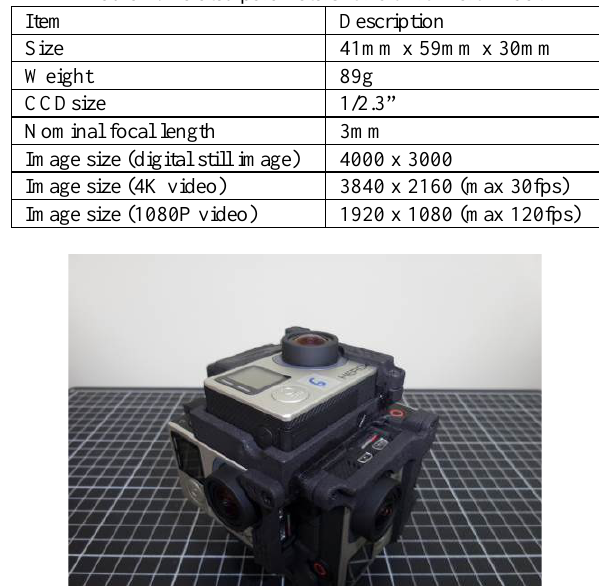
Figure 1. Multiview GoPro System.